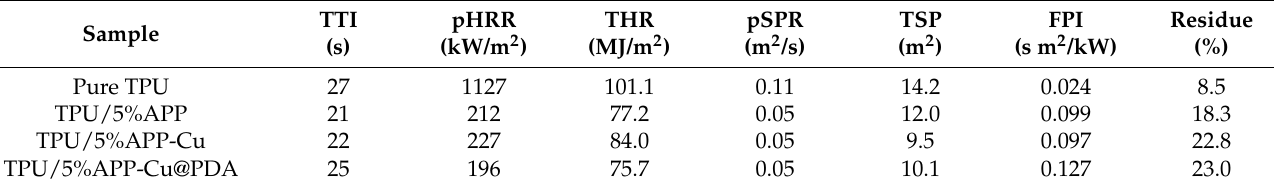
Figure 6. ( a ) HRR, ( b ) THR, ( c ) SPR, ( d ) TSP, ( e ) CO production, and ( f ) CO 2 production curves of pure TPU and TPU composites. Table 3. CCT data for TPU and TPU composites.